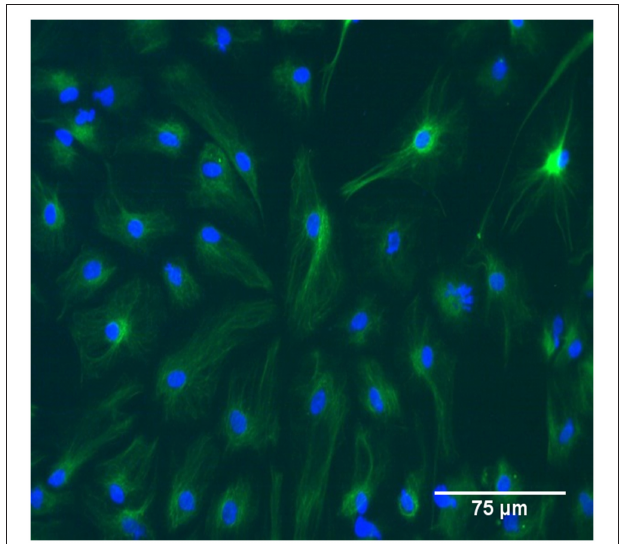
FIGURE 1 | The study population was GFAP-positive primary rat astrocytes between passage zero and four. In the image cells were immunolabeled with GFAP and tagged with FITC. Scale bar is 75 µ